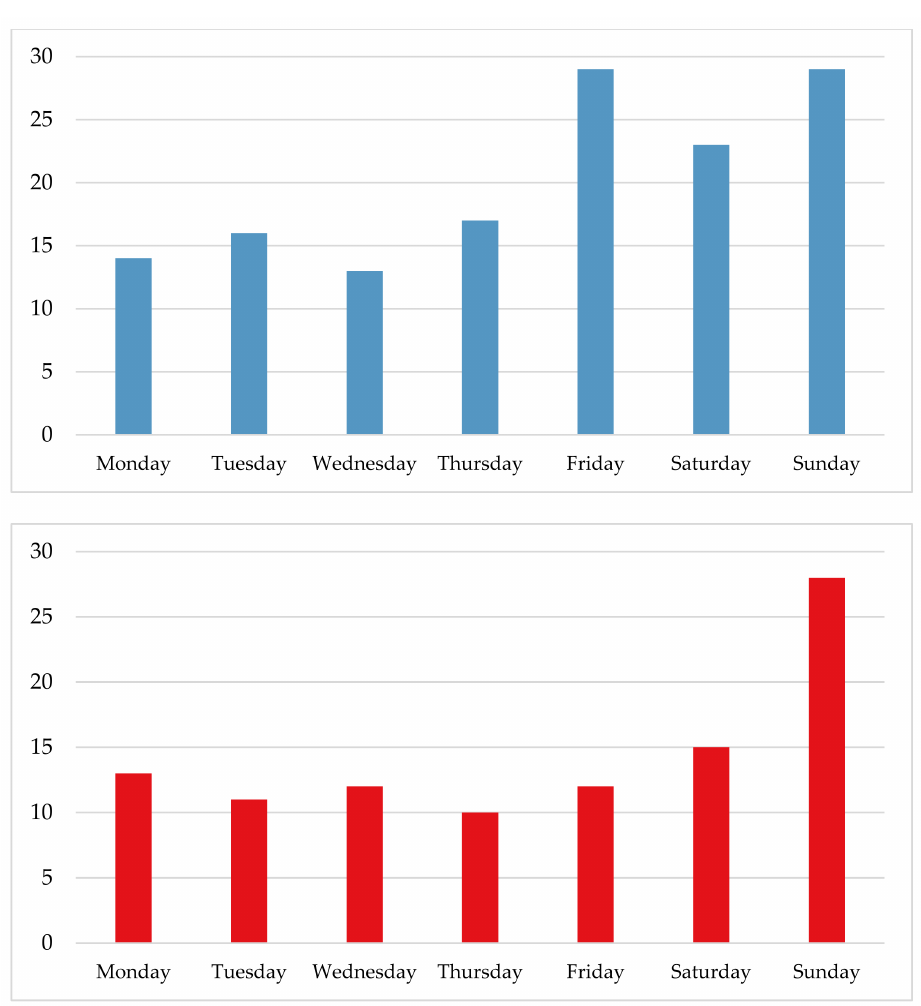
Figure A3. Reports of gunshots pre-COVID-19 (blue) and during COVID-19 (red) in Mexico City for each day of the week. Source: Authors’ own with office